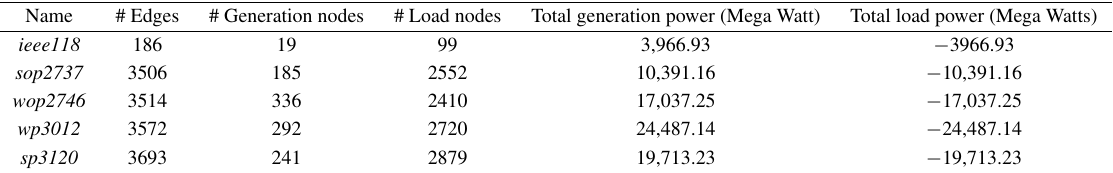
Table 1. The information of the five power